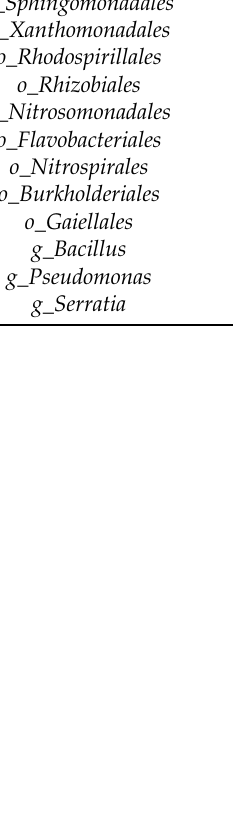
Table 2. Comparison of α -diversity parameters in different